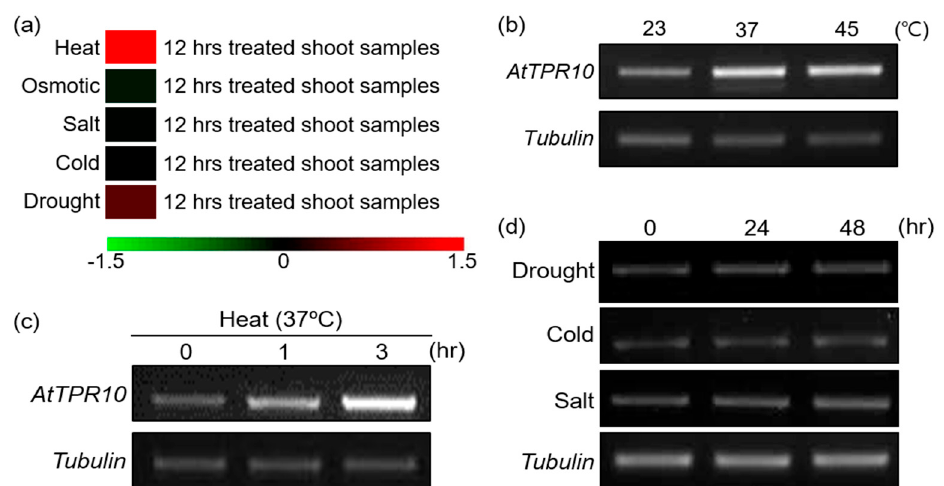
Figure 3. Expression analysis of AtTPR10 under diverse abiotic stresses via bioinformatics database searches. ( a ) Effect of AtTPR10 expression in Arabidopsis by the treatment of abiotic stress examined in the database of Arabidopsis eFP Browser v2.0 (http://bar.utoronto.ca/efp2/Arabidopsis/Ara-bidopsis_eFPBrowser2.html). ( b )–( d ) RT-PCR analysis of AtTPR10 expression in two-week-old WT (Col-0)